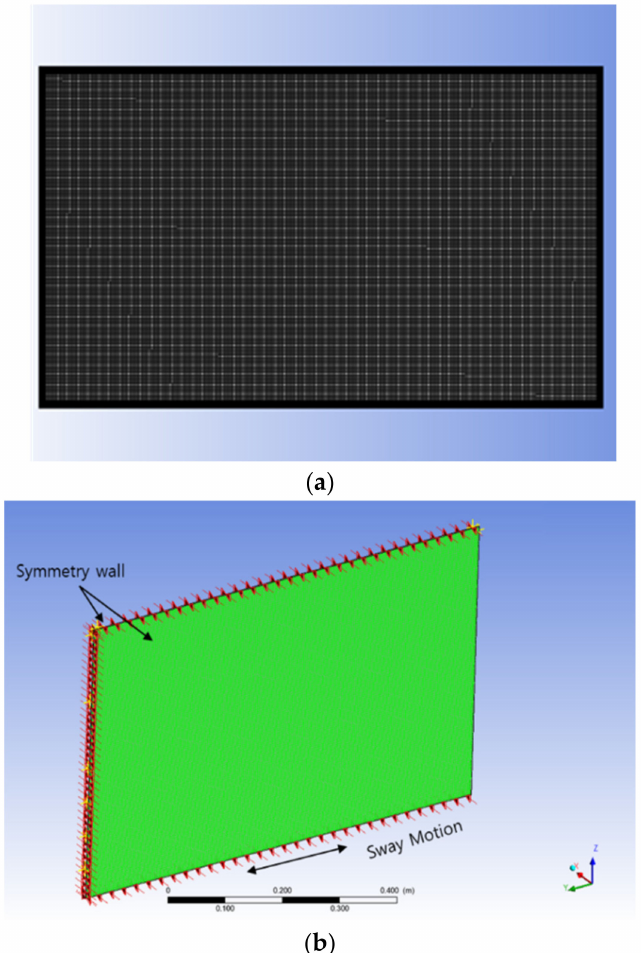
Figure 5. Computational grid ( a ) and boundary condition ( b ) for sloshing model test